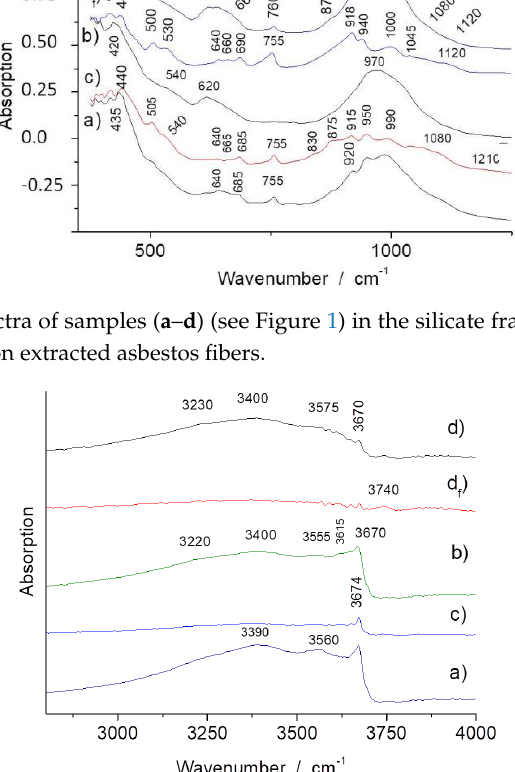
Figure 3. FTIR ATR spectra of samples ( a – d ) (see Figure 1) in the silicate framework spectral range; ( d f ) spectrum recorded on extracted asbestos fibers.